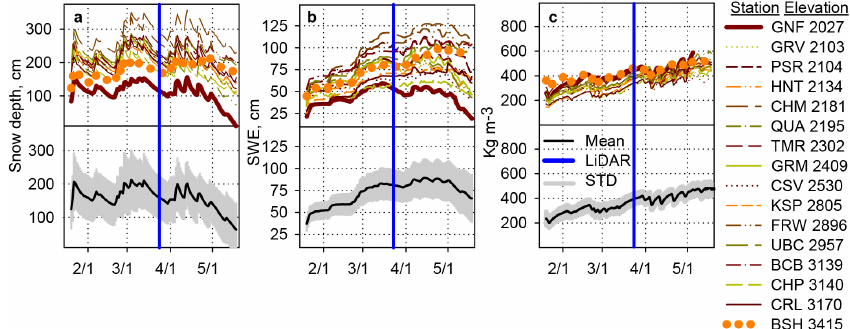
Figure 7. In situ measurements of (a) snow depth, (b) SWE and (c) density for all west-slope snow-pillow and depth sensors in sites located within 1 ◦ latitude of study area. Upper halves of the panels show data for individual stations, with highest and lowest elevations plotted in bold. Lower halves of the panels show mean in black, with + 1 standard deviation shaded in gray; vertical blue line indicates 23 March LiDAR acquisition dates. Figure 1 shows station names and locations.